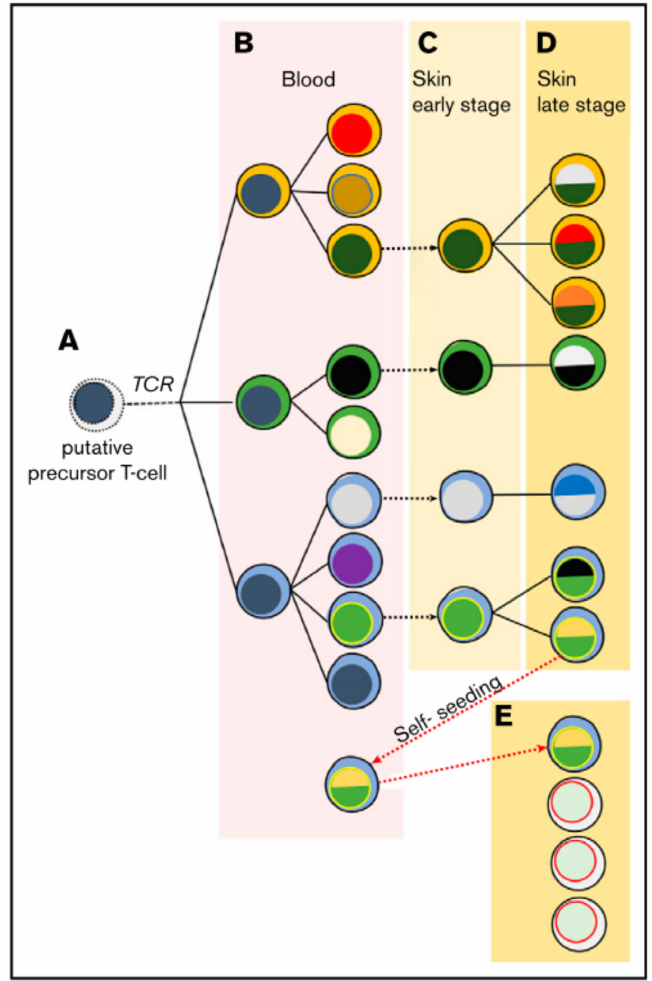
Figure 1. Suggested model of migrating malignant cells in CTCL. As a result of circulating and self-seeding malignant cells to other lesions, intra-patient heterogeneity may occur. ( A ) A putative precursor of a malignant T-cell undergoes malignant transformation before TCR-beta rearrangement, showing clonotypic heterogeneity (different cytoplasm colour). ( B ) In the blood the precursor expands and accumulates mutations, leading to different subclones (different colour of nucleus). ( C , D ) Lesions are seeded by malignant T-cells, where they progress malignancy and develop new subclones while disease further develops. ( E ) Some malignant cells may re-enter the circulation to self-seed into other lesions, increasing heterogeneity and disease progression. Reprinted with permission from ref.